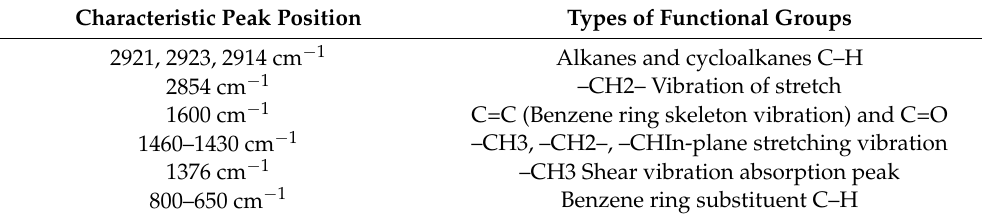
Figure 4. Fourier infrared spectroscopy of modified asphalt. ( a ) SBS/Saso; ( b ) SBS-T/Saso; ( c ) SBS-W//Saso. Table 5. Characteristic peak information of functional groups of modified asphalt by infrared spec ‐ trum.